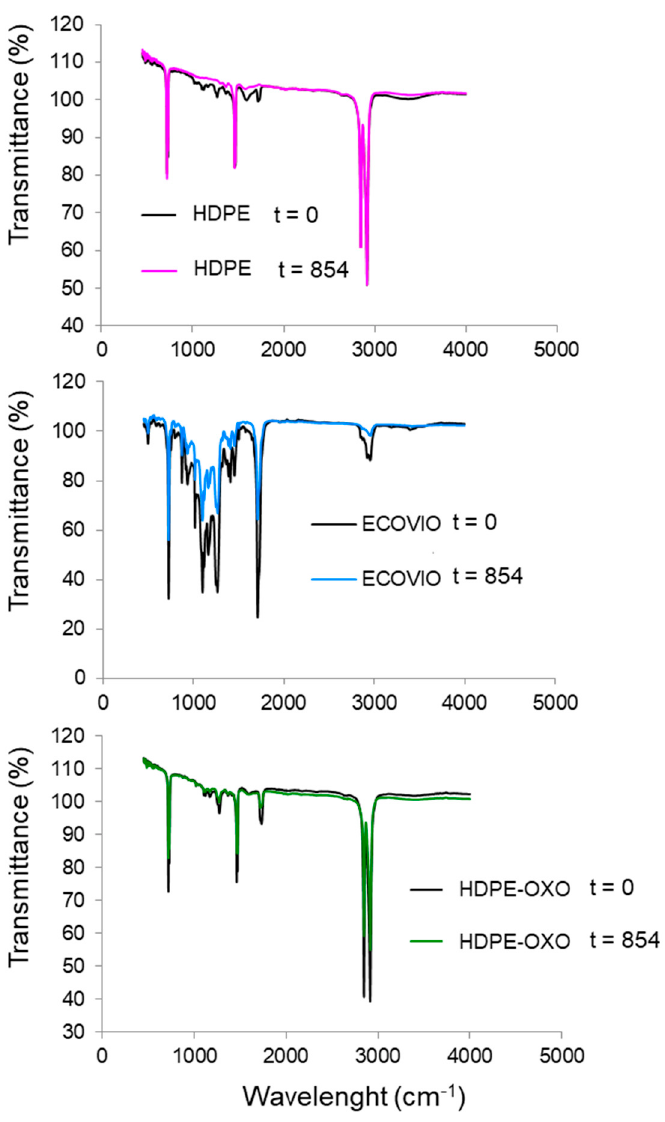
Figure 3. Infrared spectra of high-density polyethylene, compostable plastic ECOVIO ® , and oxo- degradable polyethylene films before (t = 0) and after degradation (t = 854 days). degradable polyethylene films before (t = 0) and after degradation (t = 854